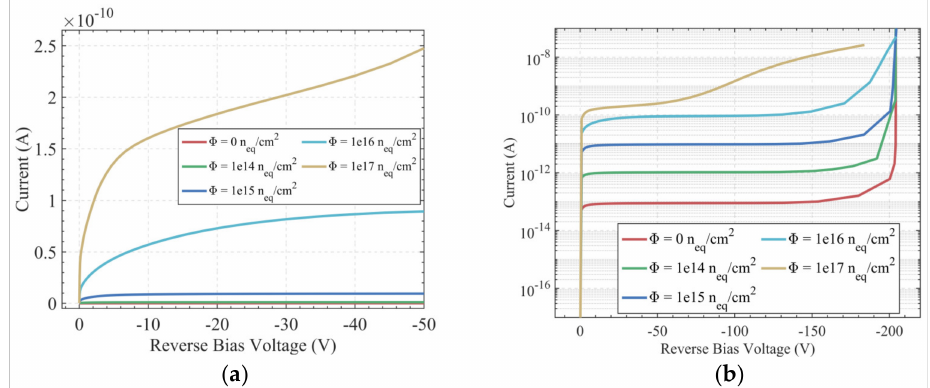
Figure 5. Leakage current of the hemispherical electrode detector; ( a ) Leakage current with bias voltage of − 50 V; ( b ) Leakage current with bias voltage of − 200 V.